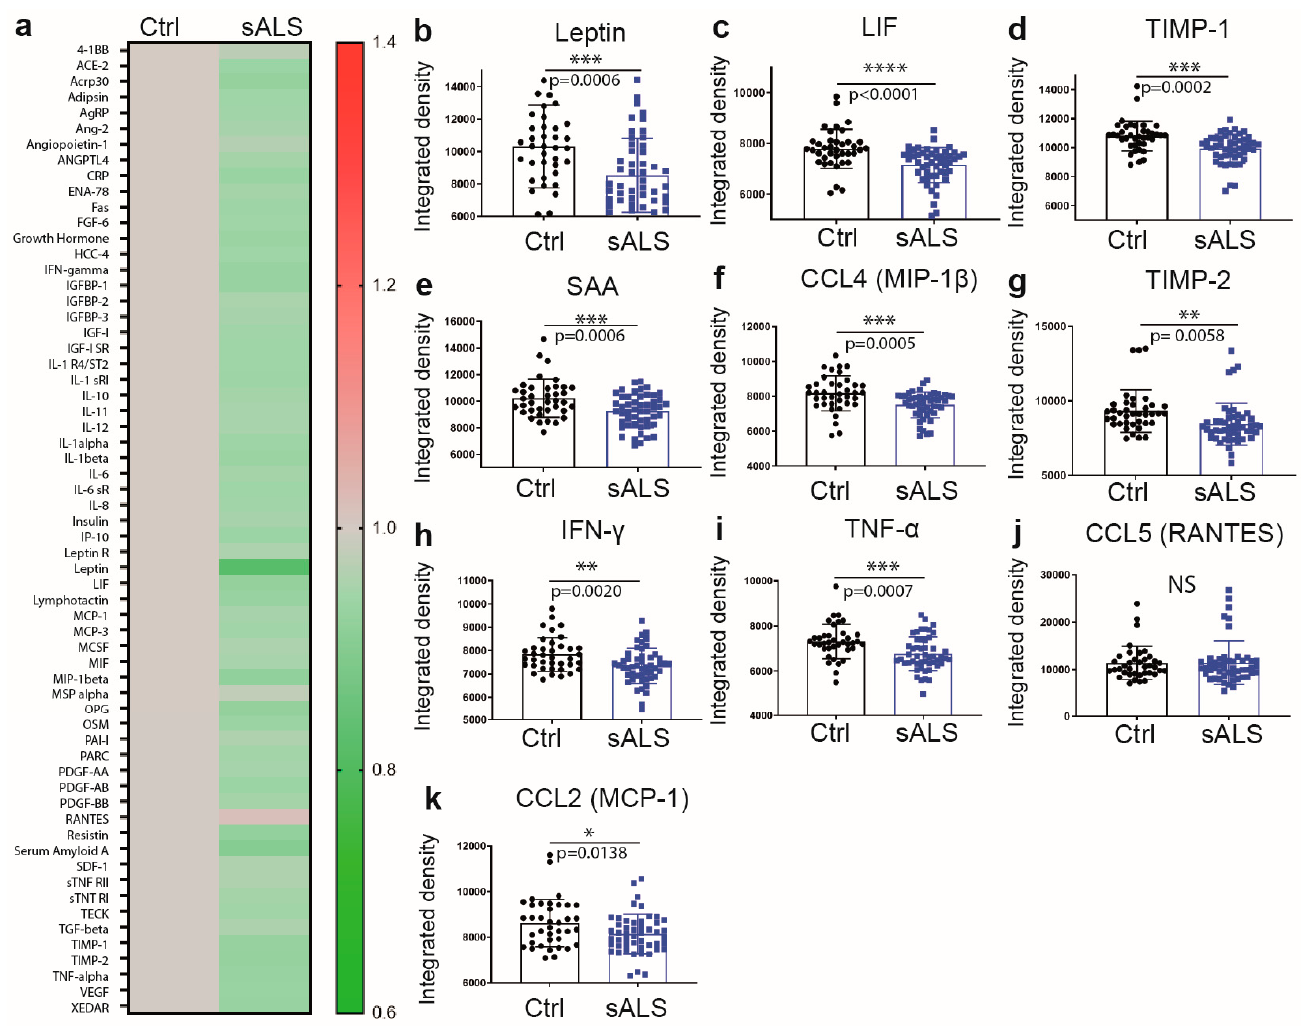
Figure 1. Cytokines/adipokines/chemokines profile in sALS patients. ( a ) Heat map illustrating changes in cytokines/adipokines and chemokines levels (ratio) in sALS patients (51) as compared to healthy controls (38) measured by cytokines array. ( b – k ) individual graphs with significant variations. Human Obesity Array is a semi-quantitative method with arbitrary measures (integrated density) (Data are mean ± SEM * p ≤ 0.05, ** p < 0.01, *** p < 0.001, **** p < 0.0001, NS, not significant).